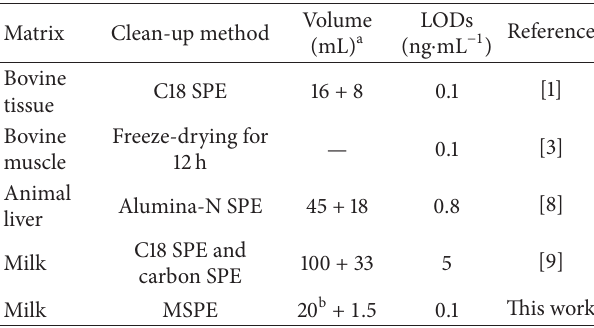
Table 1: Comparison of the sample preparation procedures between different